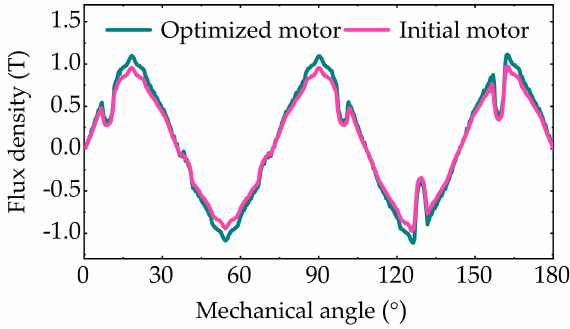
Figure 10. The flux density of the initial motor and the optimized motor.